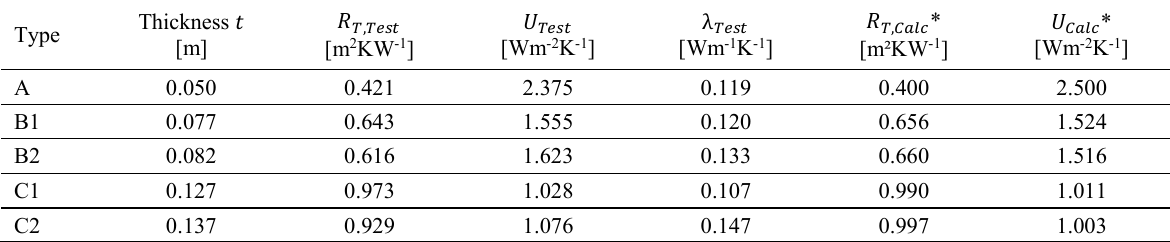
Table 2: Thermal insulation properties of wall elements made of timber and WLC.